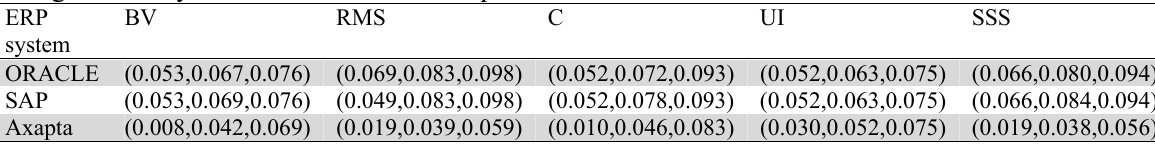
Weighted Fuzzy decision matrix for example